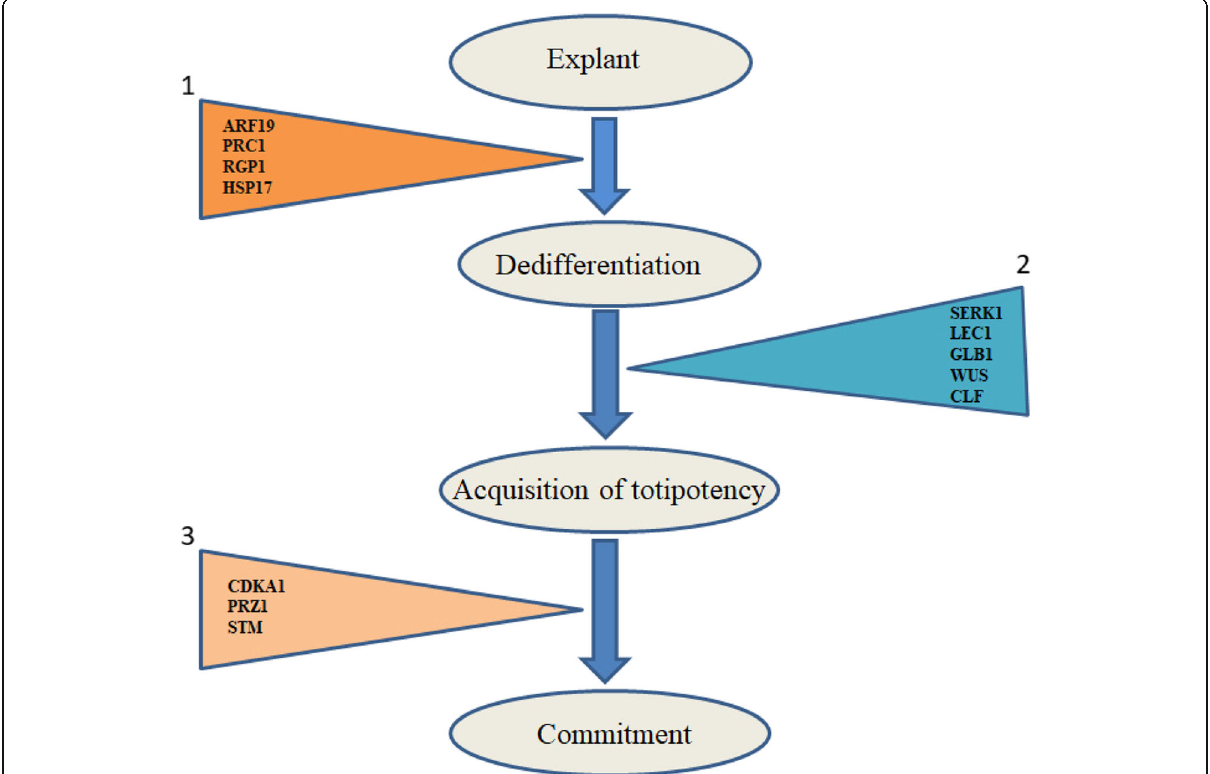
Fig. 2 Different genes at different stages of SE pathway. Triangle 1 in yellow shows genes involved in dedifferentiation; triangle 2 shows genes involved in acquisition of totipotency by the cells; and triangle 3 shows genes expressed in commitment of totipotent cells to embryogenic state. AUXIN RESPONSE FACTOR 19 (ARF19), POLYCOMB REPRESSIVE COMPLEX 1 (PRC1), REVERSIBILY GLYCOSYLATED POLYPEPTIDE 1 (RGP1), HEAT SHOCK PROTEIN 17 (HSP17), SOMATIC EMBRYOGENESIS LIKE RECEPTOR KINASE (SERK1), LEAFY COTYLEDON1 (LEC1), GALACTOSIDASE BETA 1 (GLB1), WUSCHEL (WUS), CURLY LEAF (CLF), CYCLIN DEPENDENT KINASE A1 (CDKA1), PROPORZ1 (PRZ1), SHOOT MERISTEMLESS